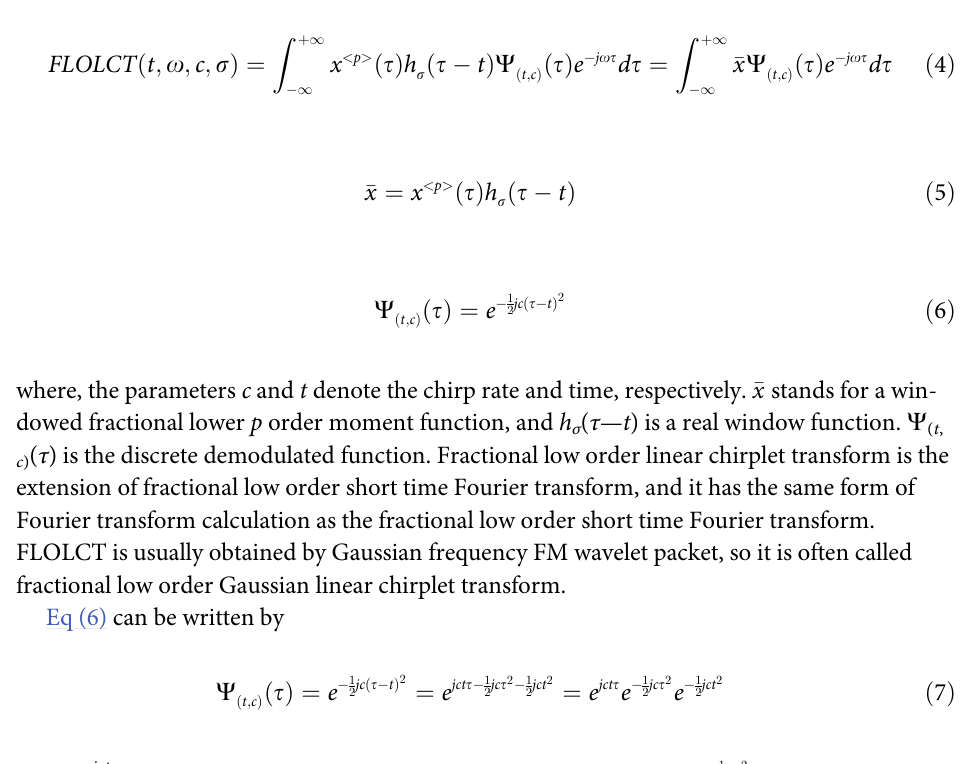
According to the definition of the FLOSTFT in Eq (2) and liner chirplet transform (LCT) [13, 14], we define fractional lower order liner chirplet transform (FLOLCT) as